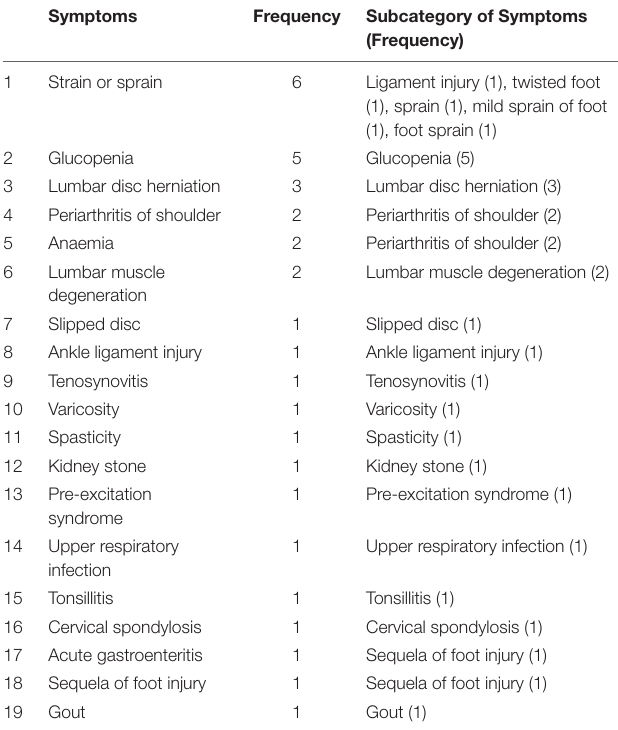
TABLE 3 | Preliminary summary of disease